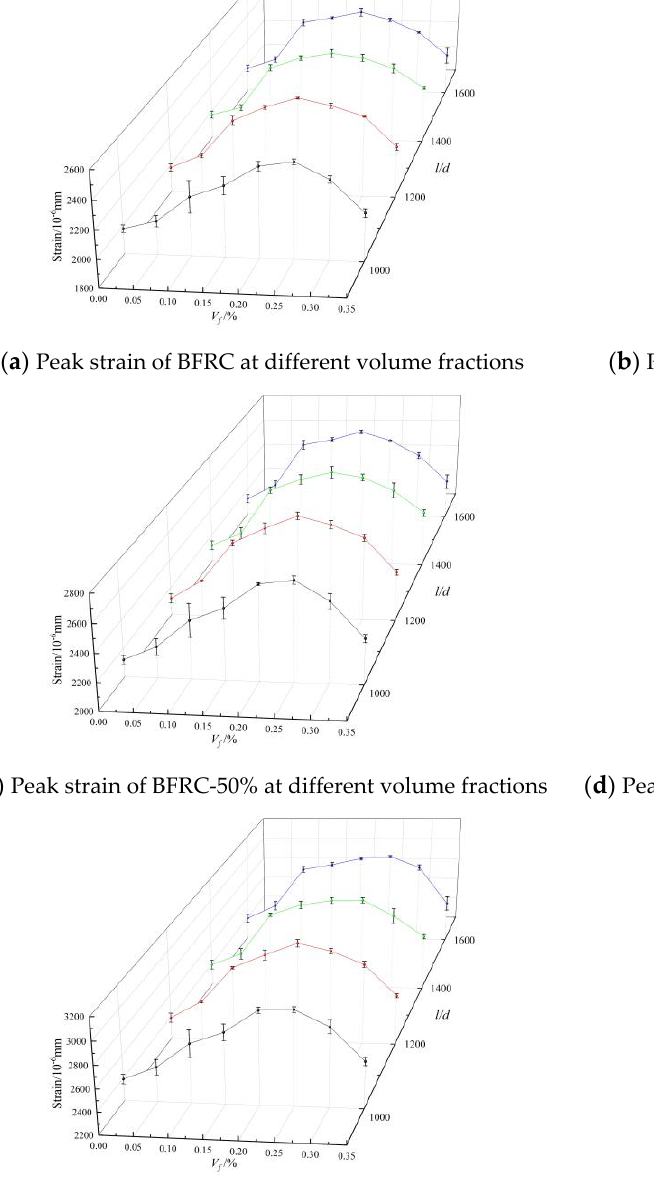
Figure 11. Peak strain of BFRAC under uniaxial compression.